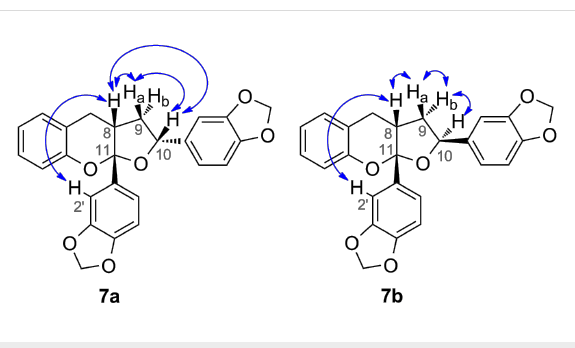
Figure 3: NOESY correlations in isomers 7a and 7b .